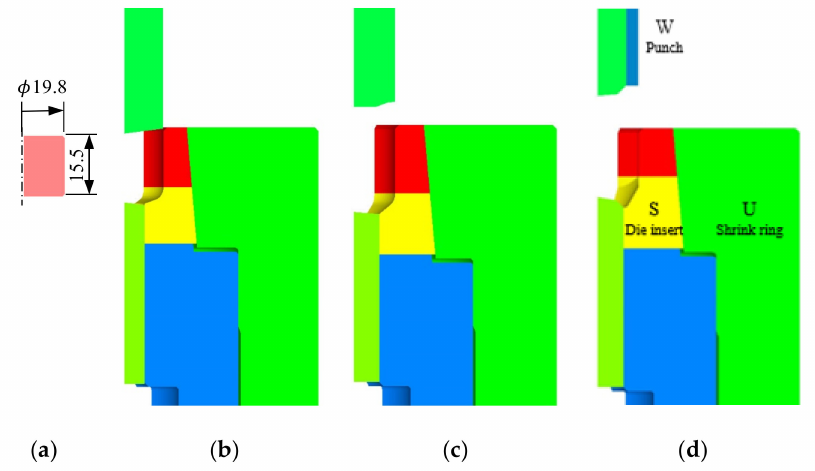
Figure 1. Initial workpiece and die designs of the selected nut cold forging stages: ( a ) workpiece; ( b ) stage 1; ( c ) stage 2; ( d ) stage